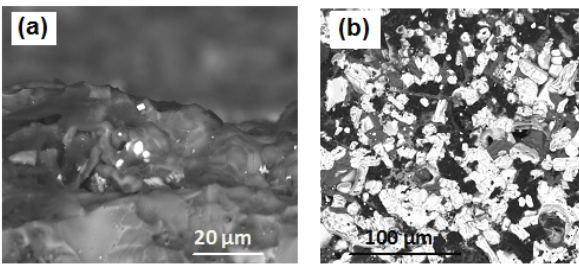
Fig. 7 BSE images of (a) oxide layer and (b) parent composite of PLRS 2.0 after 10 min exposure to plasma flame at 2700 ℃ .